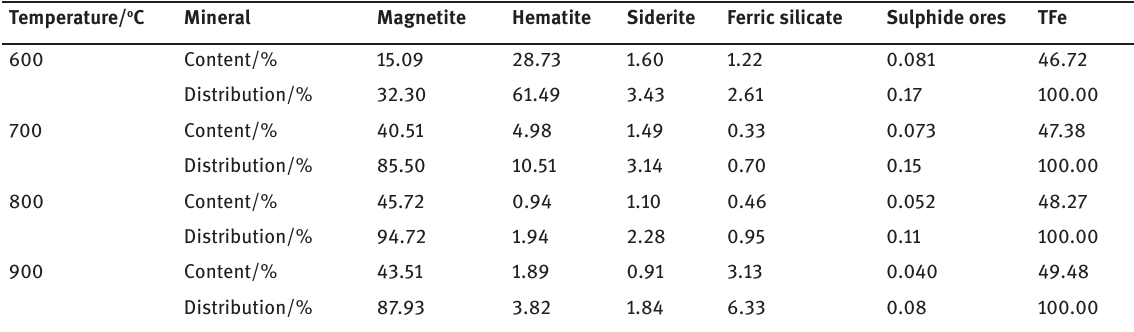
Table 6: Fe mineral phases (distribution) at roasting temperatures 600 ~ 900 o C. Temperature/ o C Mineral Magnetite Hematite Siderite Ferric silicate Sulphide ores